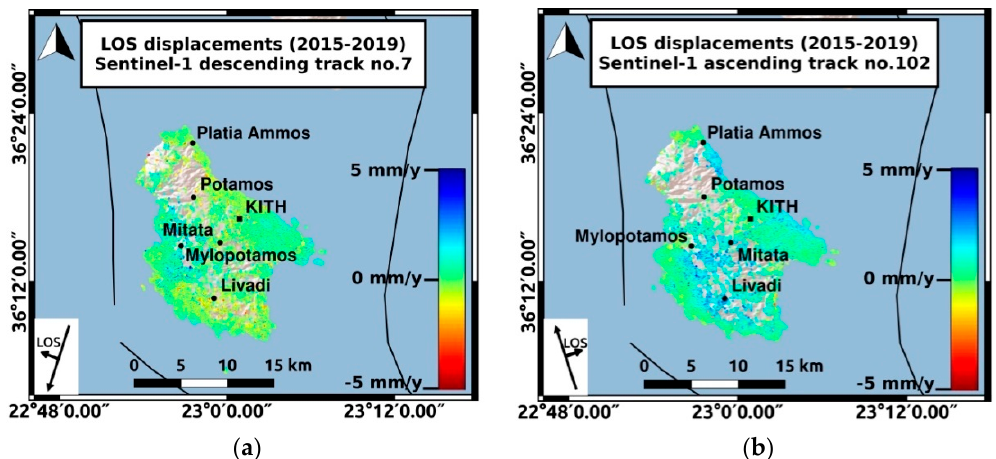
Figure 4. Persistent scatterers (PS) LOS displacements of Sentinel-1 data. ( a ) Ascending track no. 102; ( b ) Descending track no. 7.